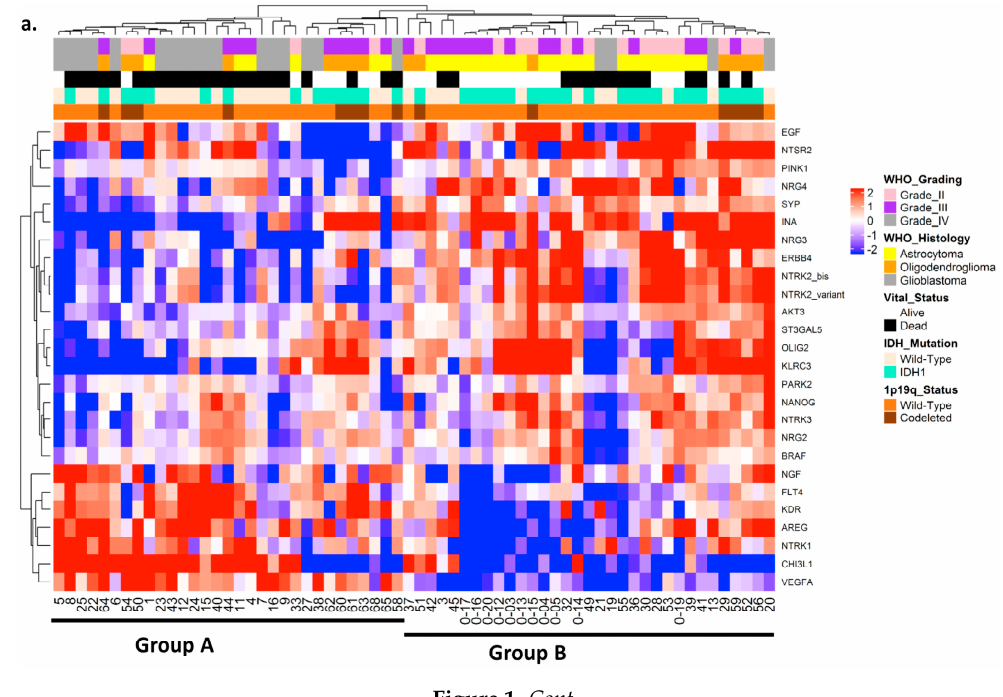
Figure 1. Cont Figure 1. Cont.